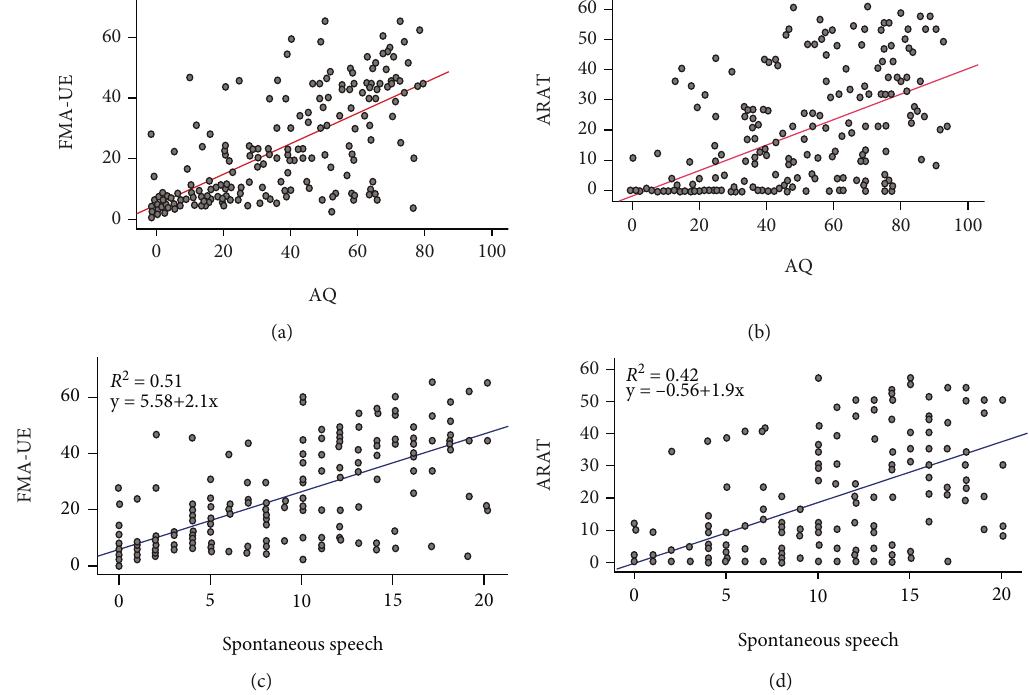
Figure 3: Correlation and regression in independent evaluation scores. (a, b) The association of AQ with FMA-UE and ARAT is shown. (c, d) The correlation of spontaneous speech and FMA-UE and ARAT is shown using linear regression equation. p < 0 : 001 . FMA-UE indicates the Fugl-Meyer Assessment of the Upper Extremity; ARAT indicates the action research and action test; AQ indicates the Western Aphasia Battery-Aphasia